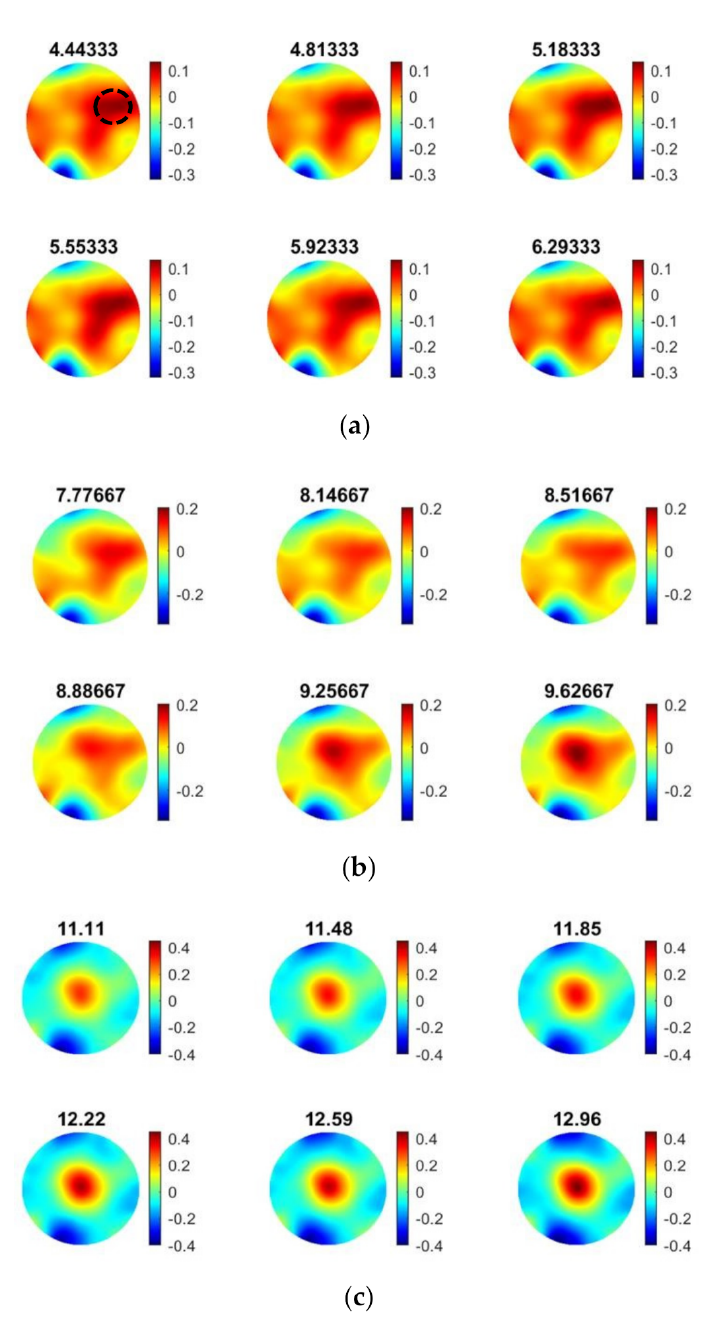
Figure 11. Ultrasound reconstructions during the calcium carbonate crystallization process (Trial 1 in Figure 8). Mixing speed of 100 RPM and feed addition rate of 40 mL min − 1 . Parts a and b show the feeding points and c and d represent the crystal formation process. USCT reconstruction during experiments: ( a ) from T + 3.3 min to T + 6.29 min, ( b ) from T + 6.6 min to T + 9.6 min, ( c ) from T + 10 min to T + 12.9